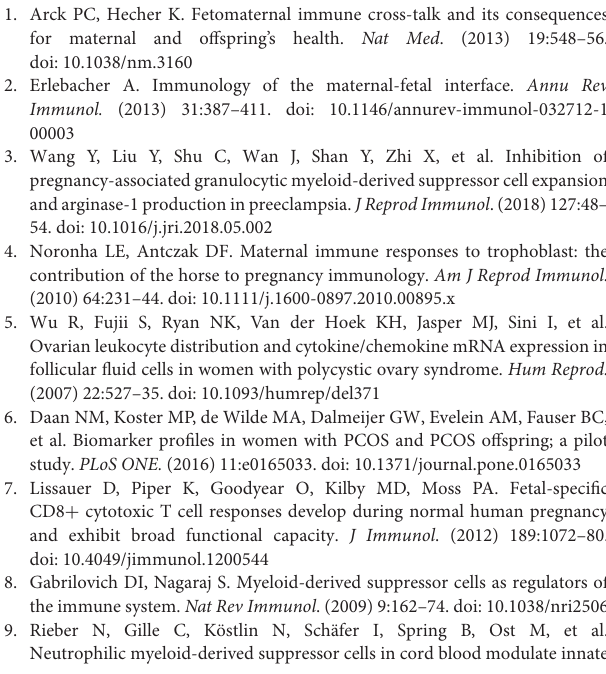
Supplemental Figure 1 | Statistical analysis of correlation among percentage of MDSC in PBMC, E 2 , S100A9 and VEGF level. (A) Correlation between percentage of G-MDSC in PBMC and serum E 2 level when serum E 2 level more than 4,000 pg/ml ( n = 10). (B) Correlation between percentage of M-MDSC in